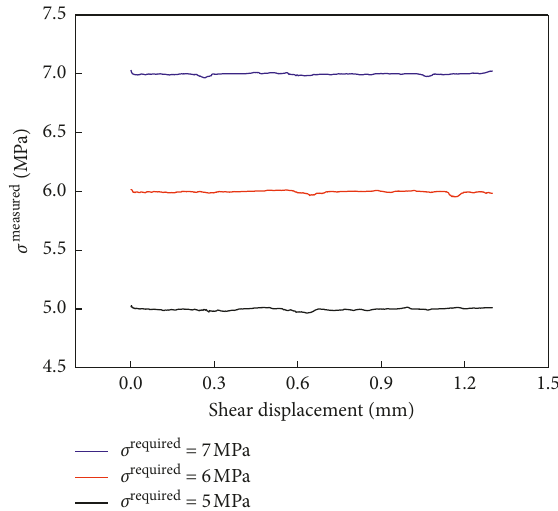
Figure 11: Comparison between actual normal stress and target normal stress.